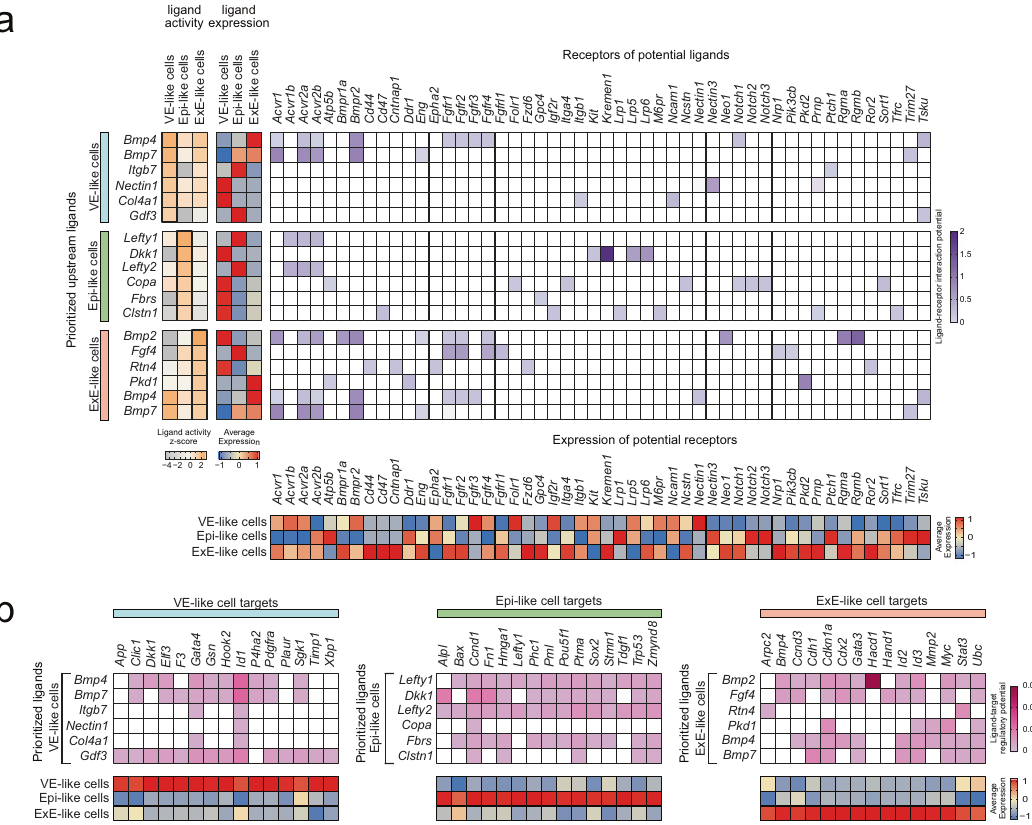
Fig. 6 Ligand-to-target interaction landscape of major compartments in RtL-embryoids. a Prioritized upstream ligands from all embryo-like compartments (left panel) based on the interaction with all other cells and their average expression (middle panel); In the right panel are potential receptors expressed by the corresponding compartment and (bottom) their average expression. b In the top panel are potential target genes of the prioritized upstream ligands and on the bottom panel their average